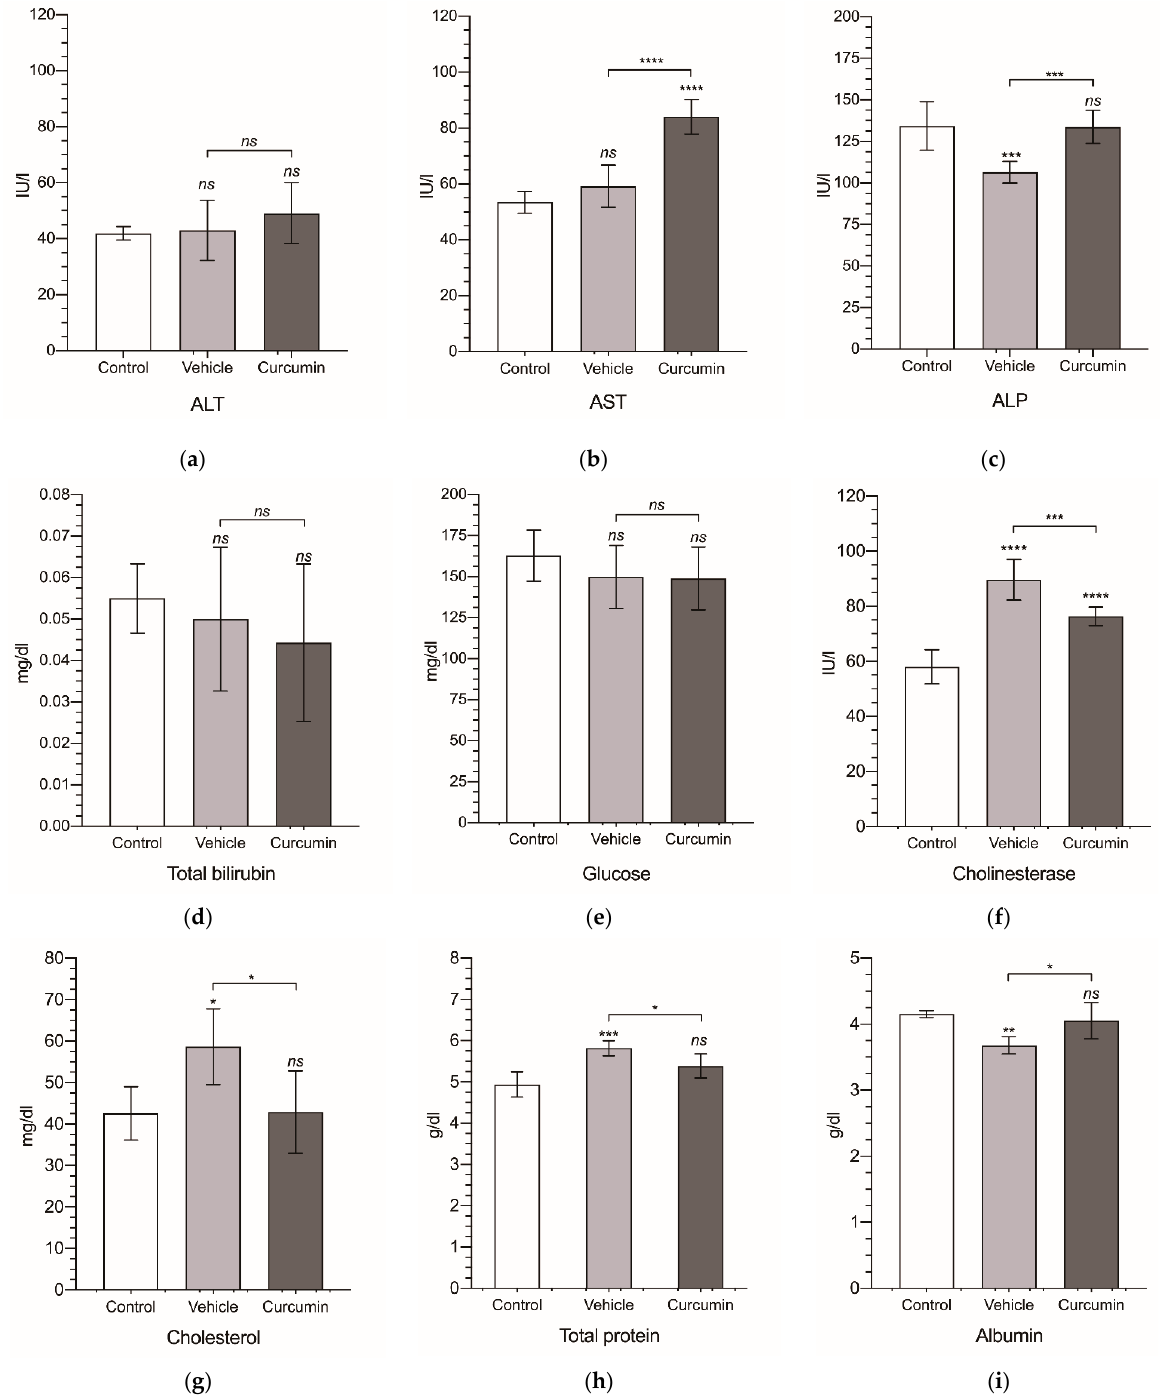
Figure 5. Biochemical serum levels. Alanine transaminase (ALT) ( a ), aspartate transaminase (AST) ( b ), alkaline phosphatase (ALP) ( c ), total bilirubin (TBil) ( d ), glucose ( e ), cholinesterase ( f ), cholesterol ( g ), total protein (TP) ( h ), and albumin ( i ). Levels are expressed in international units of activity per liter (IU/L) for ALT, AST, ALP, and cholinesterase; in milligrams per deciliter (mg/dL) for TBil, glucose, and cholesterol; and in grams per deciliter (g/dL) for TP and albumin. Results are expressed as mean and standard deviation (SD) of a single replicate (10 animals in the vehicle- and curcumin-treated group and 6 animals for the control group). The statistical analysis was carried out by a one-way ANOVA test, followed by Newman − Keuls multiple comparison test for between-group comparisons to the control group, or between the vehicle group and the curcumin group. Asterisks indicate statistical significance: *: p < 0.05; **: p < 0.01; ***: p < 0.001; **** p < 0.0001; ns: p > 0.05. Control group represents non-tumor-bearing and non-treated animals. Table 2. Biochemical serum values for alanine transaminase (ALT), aspartate transaminase (AST), alkaline phosphatase (ALP), total bilirubin (TBil), glucose, cholinesterase, cholesterol, total protein (TP), and albumin. Levels are expressed in international units of activity per liter (IU/L) for ALT, AST, ALP, and cholinesterase; in milligrams per deciliter (mg/dL) for TBil, glucose, and cholesterol; and in grams per deciliter (g/dL) for TP and albumin. Group ALT AST ALP TBil Glucose Cholinesterase Cholesterol TP Albumin Control 41.9 ± 2.43